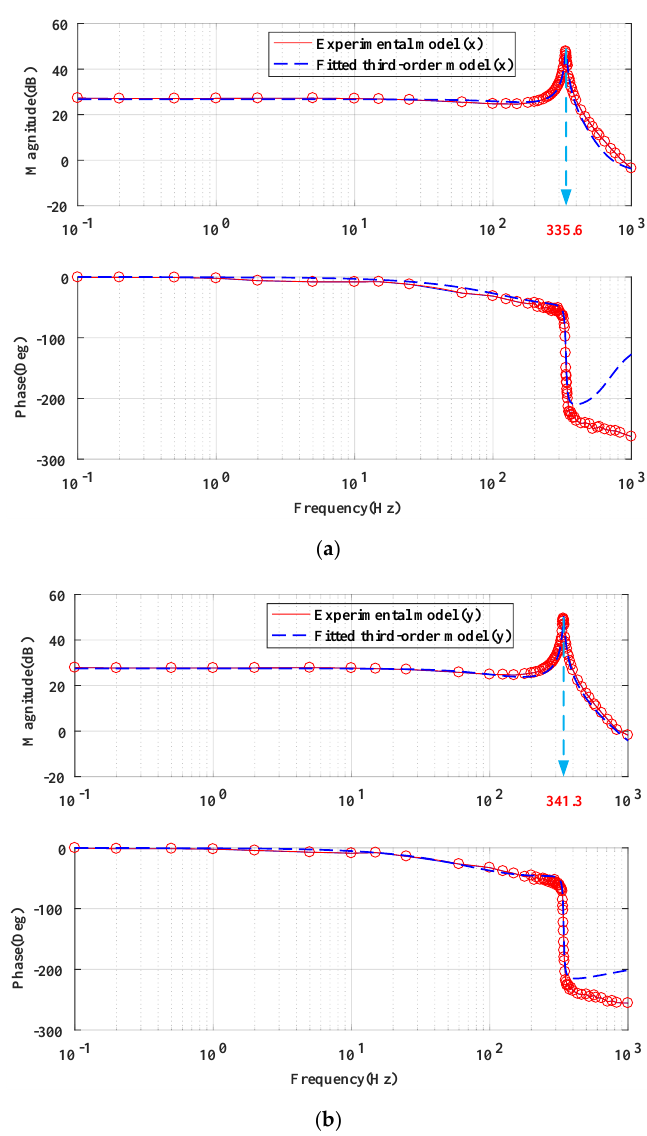
Figure 5. Experimental frequency response and fitted micromirror model. ( a ) The micromirror model of X direction. ( b ) The micromirror model of Y direction.